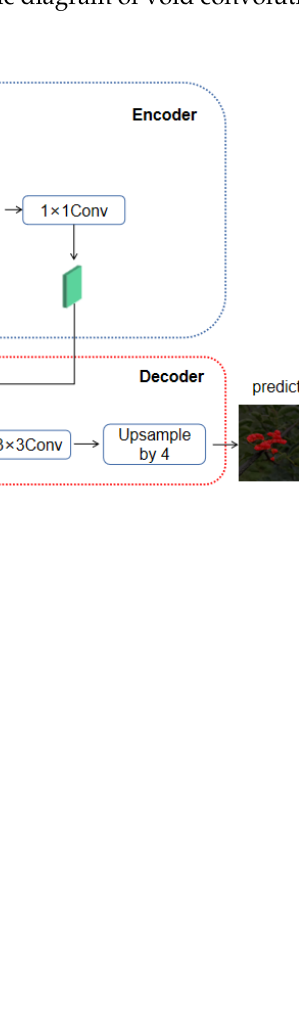
Figure 8. Dilated Convolution. Figure 8. Dilated